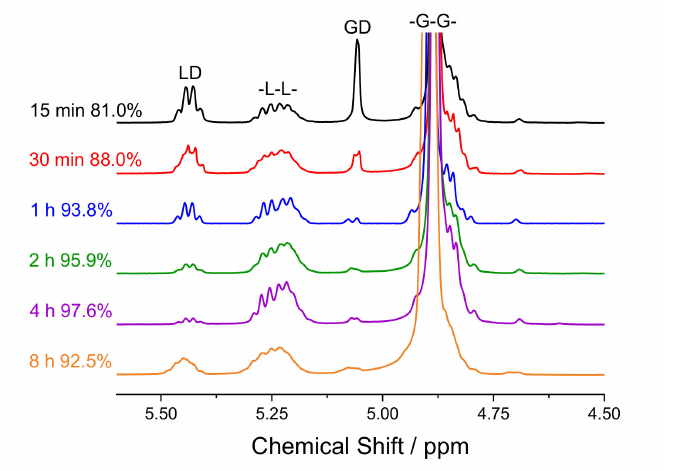
Figure 2. 1 H NMR spectra of PLGA25 synthesised at 150 ◦ C at 15 min to 8 h using an [M]:[C] = 6500:1 and [M]:[I] = 30,000:1. Conversion values are for the total monomer conversion. LD = lactide, -L-L- = PLA, GD = glycolide, and -G-G- = PGA. Table 2 and Figure S5 report the full conversion and molecular weight data for the syn- thesis of PLGA25 under these reaction conditions. In general, as the reaction temperature increased from 130 to 150 to 180 ◦ C, the time required to achieve a high total monomer con- version (>96%) fell from 8 to 4 to 2 h, respectively, with similar M n (79,600–94,300 g mol − 1 ) and M w (176,000–191,000 g mol − 1 ) values achieved in each reaction. However, this in-